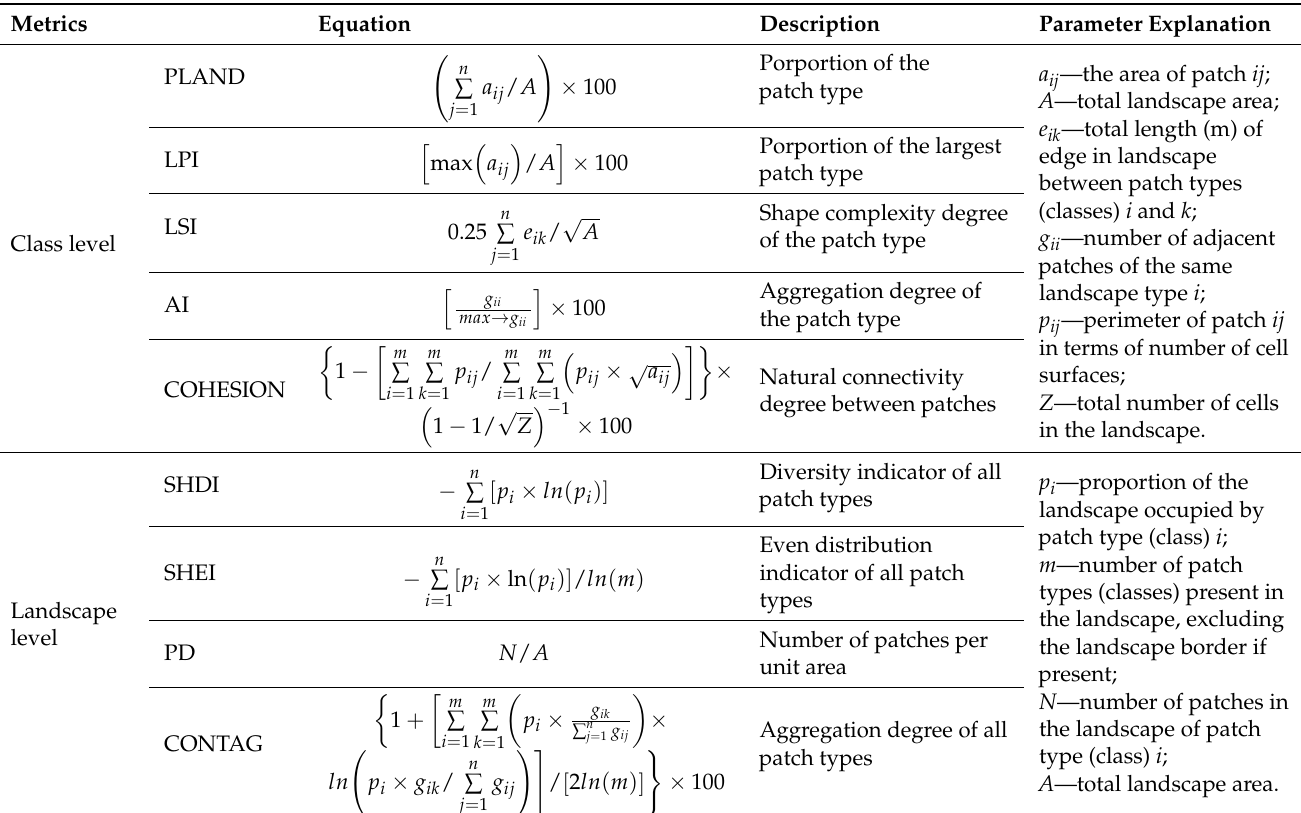
Table 4. Formulas and descriptions of landscape metrics selected in this